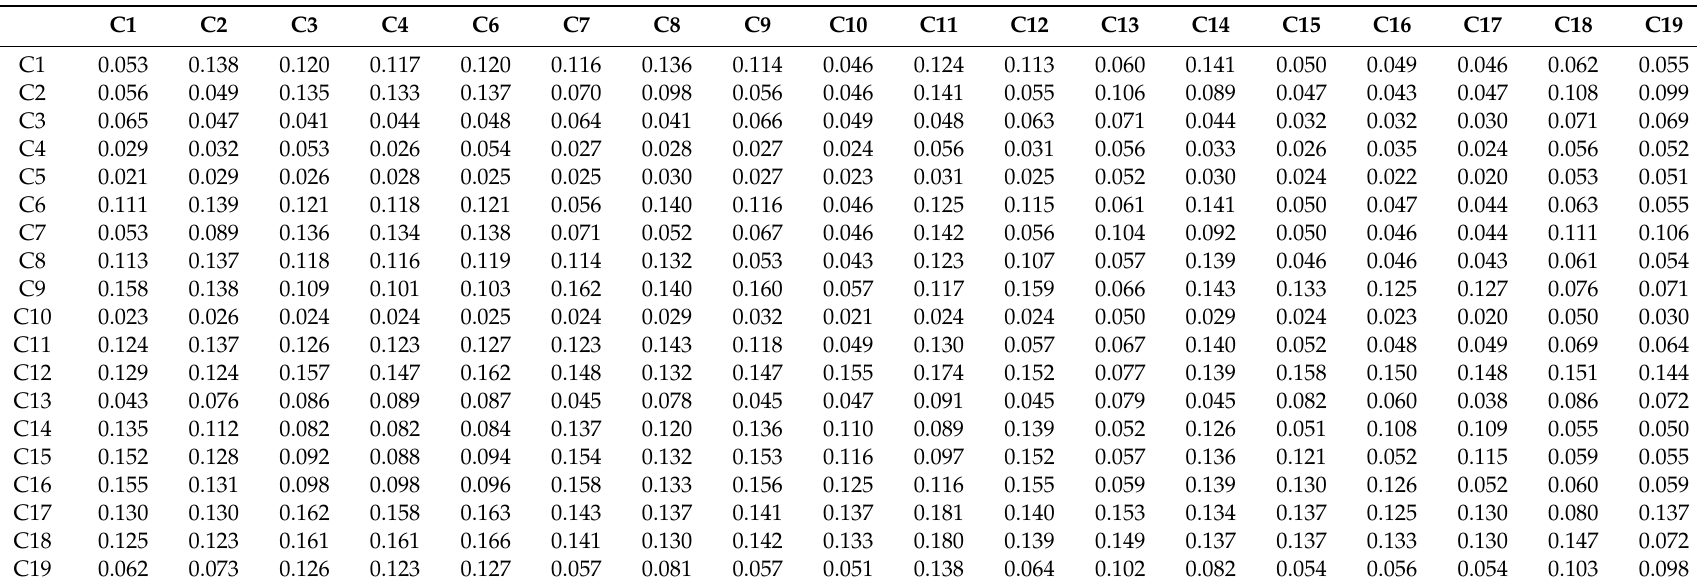
Table 5. The aggregate impact matrix